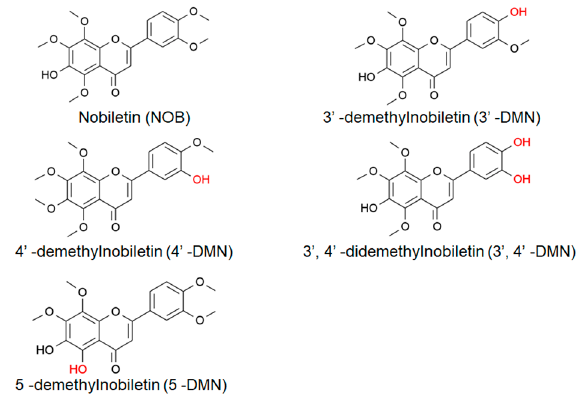
Figure 1. Chemical structures of nobiletin (NOB) and its derivatives.